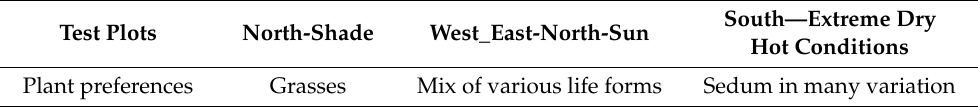
Table 18. Preferred plant mixtures on the various roof spots of this survey. Test Plots North-Shade Plant preferences Grasses Mix of various life forms Sedum in many